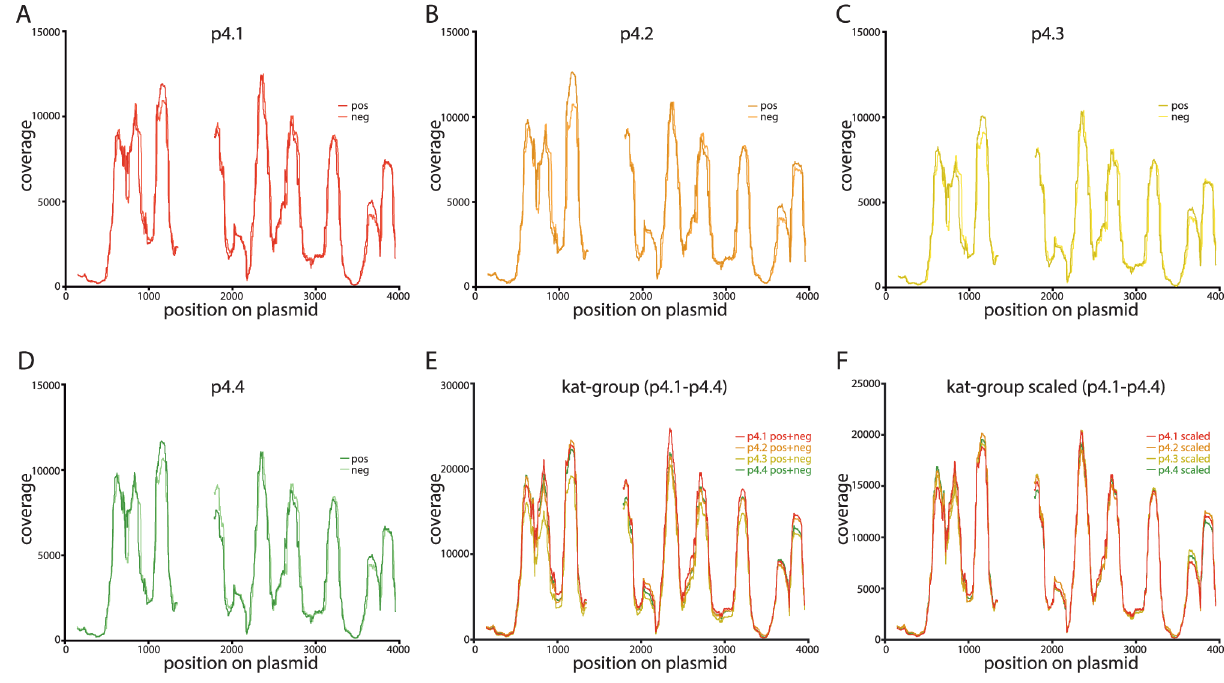
Figure 1. Invitrosome coverage plots for kat-group plasmids show near identical coverage patterns. Invitrosome coverage on each plasmid is plotted on the y-axis and the plasmid coordinates in bp are plotted on the x-axis. Gaps in the plot represent the trimmed insert site and end regions on each plasmid. 1A–1D Non-scaled coverage plots with forward (pos) and reverse (neg) invitrosomes plotted separately for plasmids p4.1-p4.4. 1E Non-scaled coverage plots with forward and reverse invitrosomes (pos + neg) combined for each plasmid. All four kat-group plasmids are shown together. 1F Combined and scaled coverage plots for all four kat-group plasmids where each plot is normalized to the plasmid with the least coverage for direct